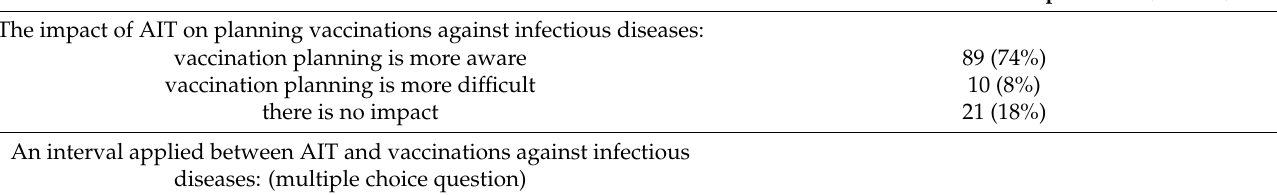
Table 6. Attitude towards safety and effectiveness of prophylactic vaccines in patients undergo- ing AIT; experience of combining AIT and vaccinations against infectious diseases, particularly influenza vaccine. Medical Professionals Respondents ( n =